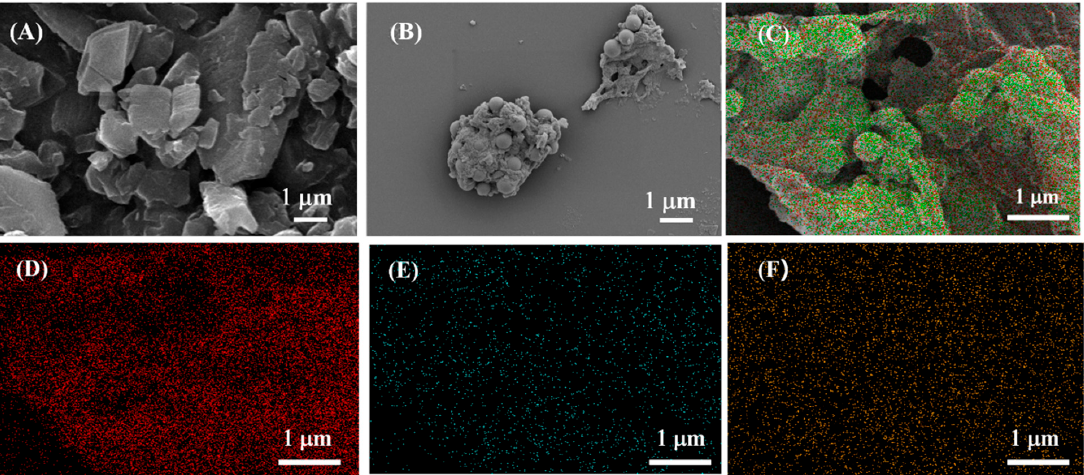
Figure 1. SEM images of ( A ) TCPP, ( B ) TCPP-Zn-(S)-BINOL. ( C – F ) EDS mapping image of TCPP-Zn-(S)-BINOL.